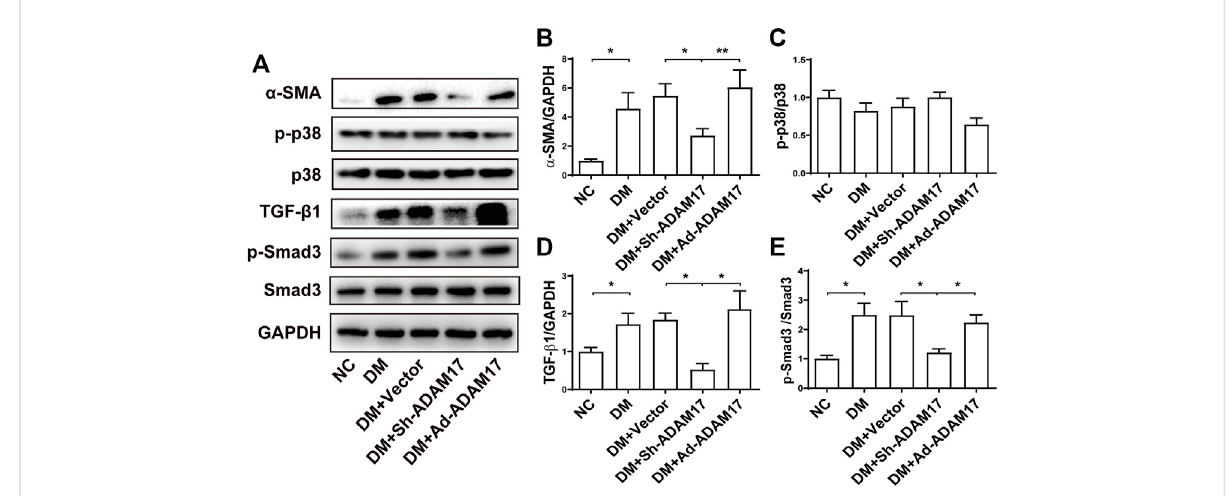
FIGURE 4 Comparison of α -SMA, p38, TGF- β 1, and Smad3 expression in 5 groups of mice. (A) Representative Western blot images of α -SMA, p-p38, p38, TGF- β 1, p-Smad3 and Smad3 in 5 groups of mice. (B) Quanti fi cation of α -SMA protein expression in 5 groups of mice . (C) Quanti fi cation of p38 phosphorylation in 5 groups of mice. (D) Quanti fi cation of TGF- β 1 protein expression in 5 groups of mice. (E) Quanti fi cation of Smad3 phosphorylation in 5 groups of mice. Data were expressed as the means ± SEM. * p < 0.05, ** p < 0.01, *** p < 0.001. n = 6 per group.